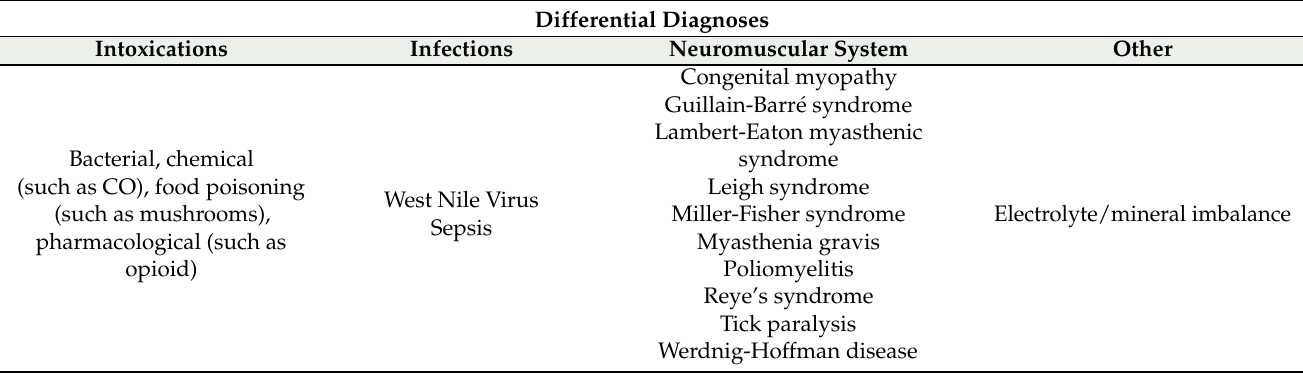
Table 3. The table shows the main pathologies for which the differential diagnosis must be made in comparison with C. botulinum intoxication. (Adapted from https://www.cdc.gov/botulism/health-professional.html, accessed date 30 June